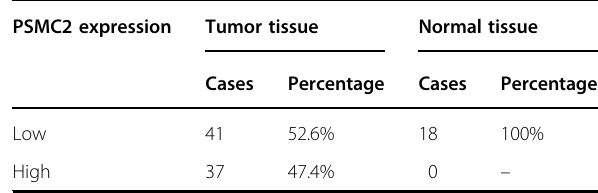
Table 1 Expression patterns of PSMC2 in gallbladder cancer tissues and normal tissues revealed in immunohistochemistry analysis.